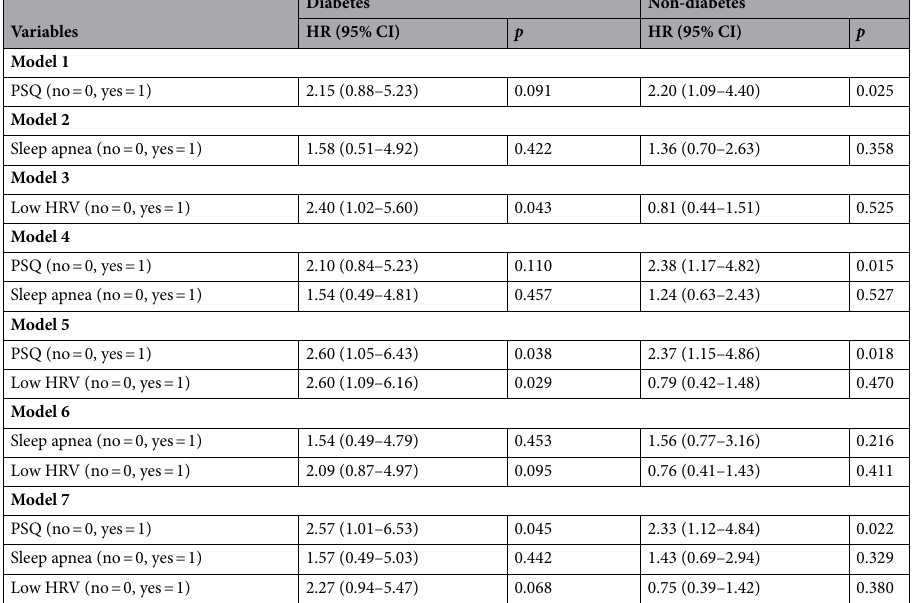
Table 3. Multivariate Cox proportional analysis of factors associated with decline in renal function. In all models used for multivariate Cox proportional hazards analysis, covariates included age, male gender, body mass index, current smoking, history of CVD, hypertension, dyslipidemia, HbA1c, baseline eGFR, and albuminuria. Model 1 included the presence of PSQ, Model 2 sleep apnea, Model 3 low HRV, Model 4 PSQ and sleep apnea, Model 5 PSQ and low HRV, Model 6 sleep apnea and low HRV, Model 7 PSQ, sleep apnea, and low HRV, in addition to the other covariates mentioned. CVD cardiovascular disease, eGFR estimated